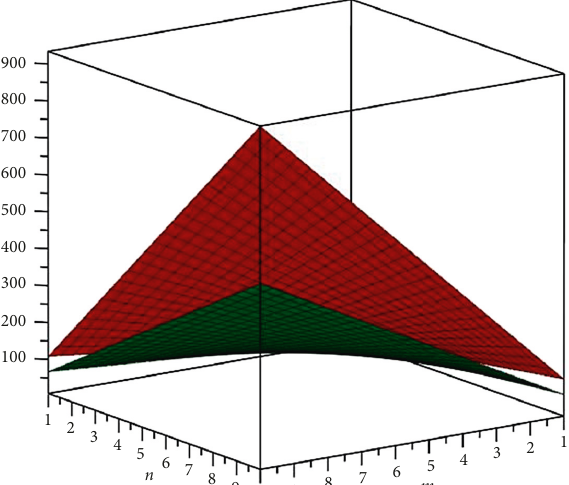
Figure 6: Graphical depiction of Table 6.